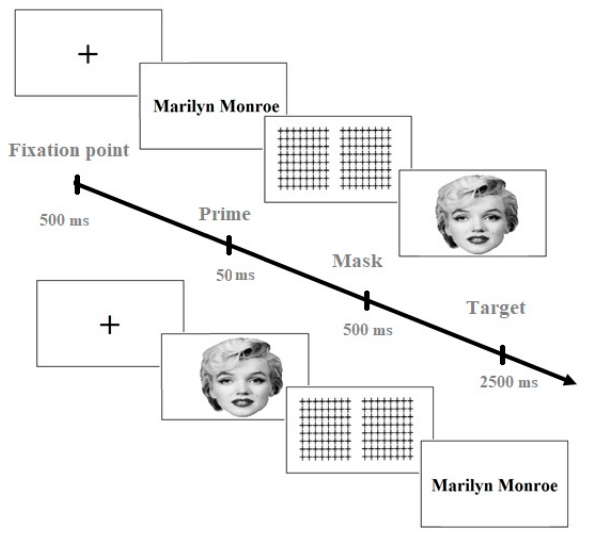
Figure 1. Examples of the related conditions on the masked priming task employed for Experiment 2. On the top, one example of block for the Prime (Celebrity word name)–Target (Celebrity face), and in the bottom one example for the block of the Prime (Celebrity face)–Target (Celebrity word name). Blocks were counterbalanced across groups.